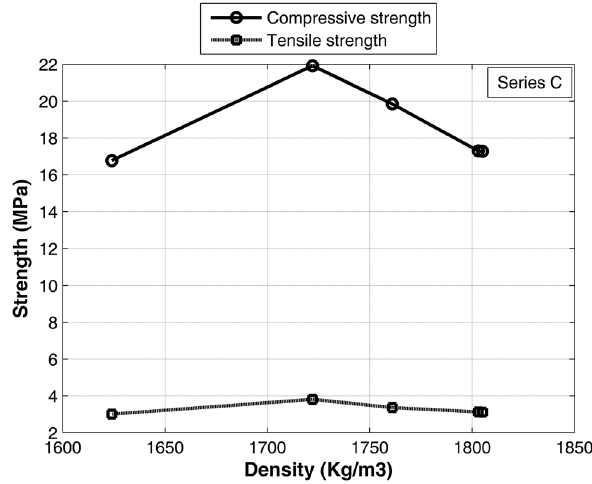
Fig. 4 Variation of strength of series C according to